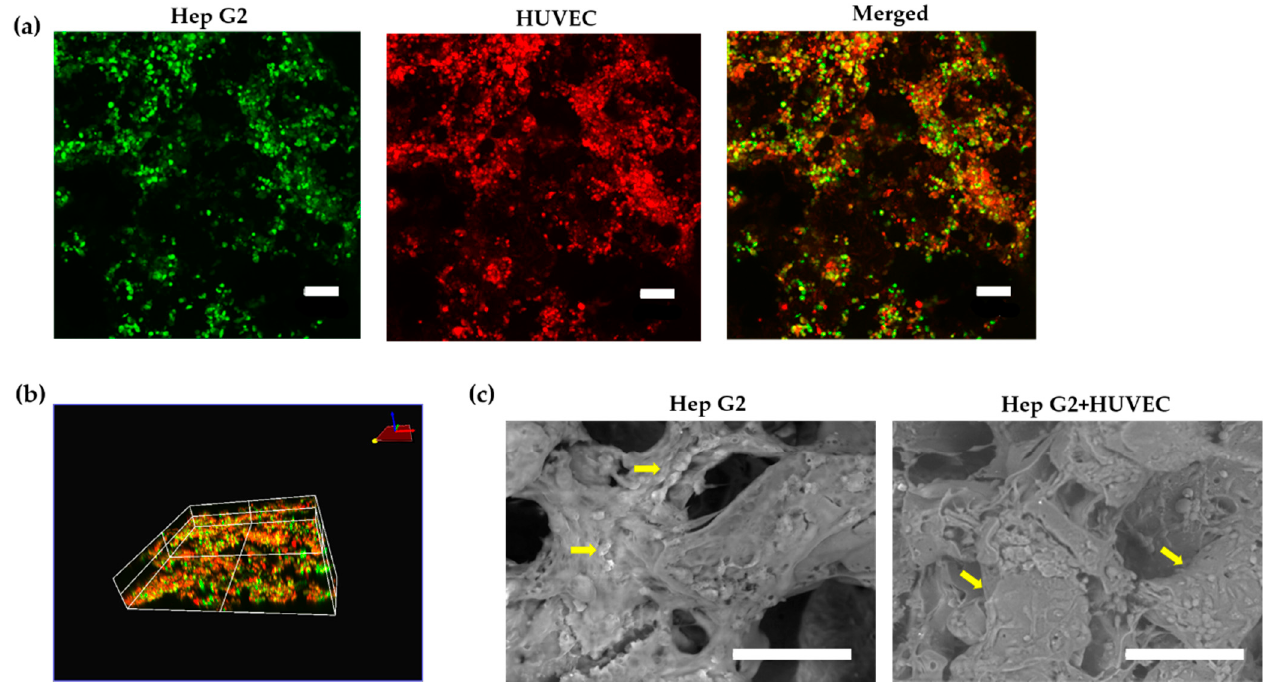
Figure 4. ( a ) Live imaging of Hep G2 and human umbilical vein endothelial cells (HUVEC) after 10 days of perfusion culture (scale bars 100 µm, magnification 4×); ( b ) volume z-stacked view of the Hep G2 and HUVEC cultured on the scaffold; ( c ) SEM images of Hep G2-covered scaffold and co-culture of Hep G2 and HUVEC at day 10. The yellow arrows show the morphology of Hep G2 and HUVEC grown on the scaffold (scale bar 100 µm, magnification 200×).